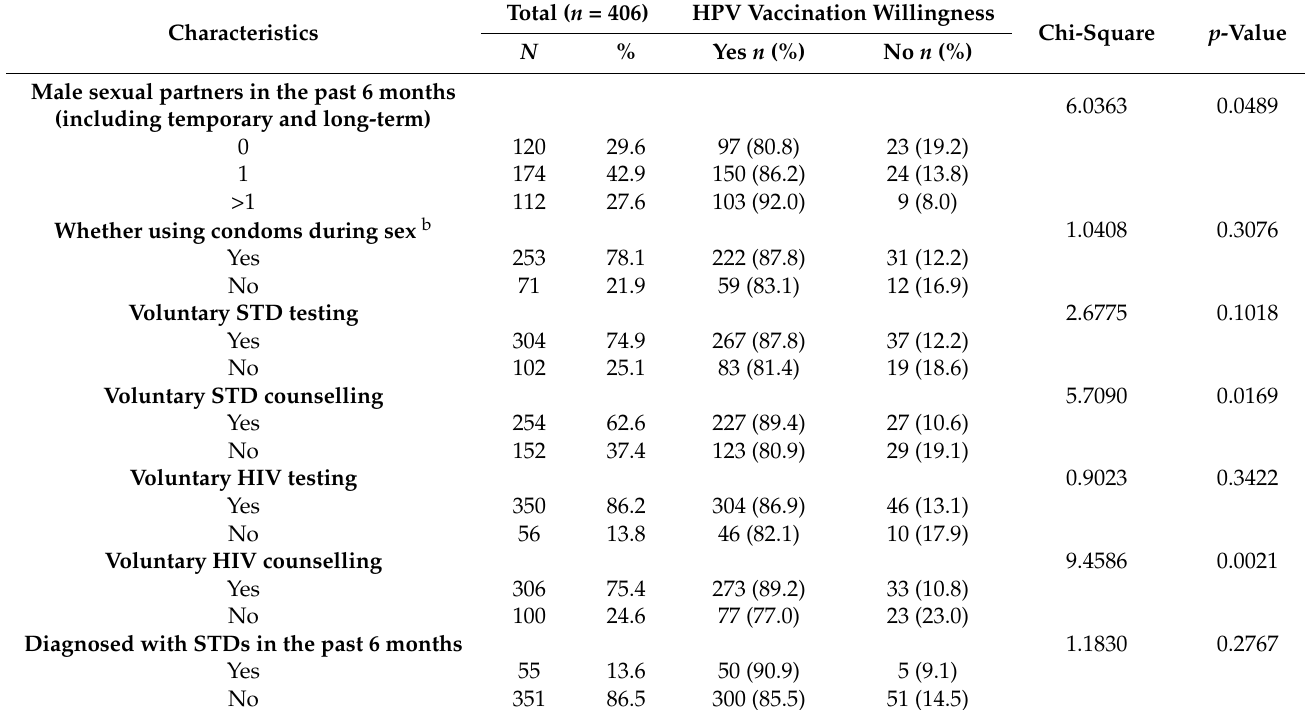
Table 2. Relationship between sexual behavior characteristics, preventive behaviors, and HPV vaccination willingness. Characteristics